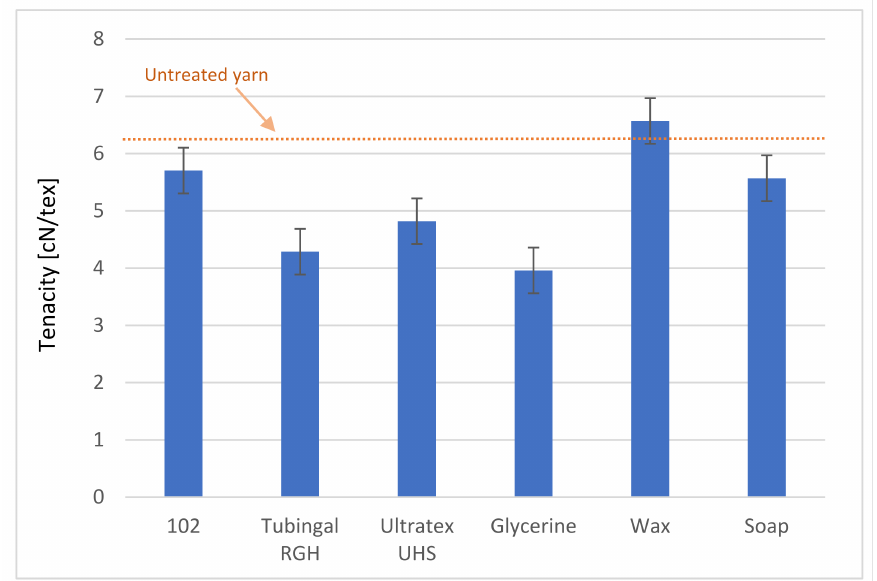
Figure 7. Effect of the finishing materials in the tenacity of paper yarn.